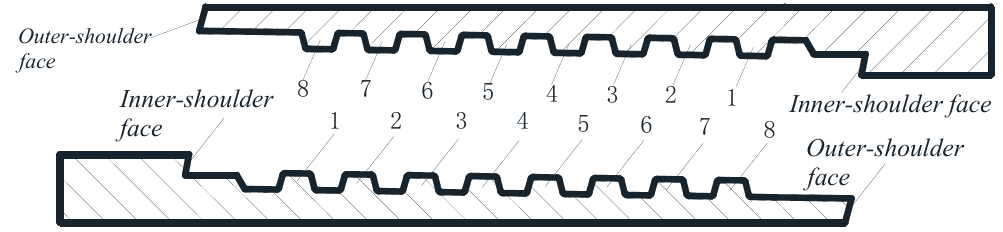
Figure 6. Schematic diagram of thread numbering.